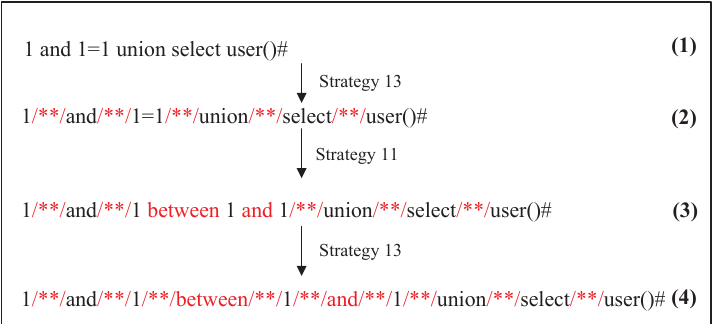
Figure 3. Dynamic variation process of the payload during